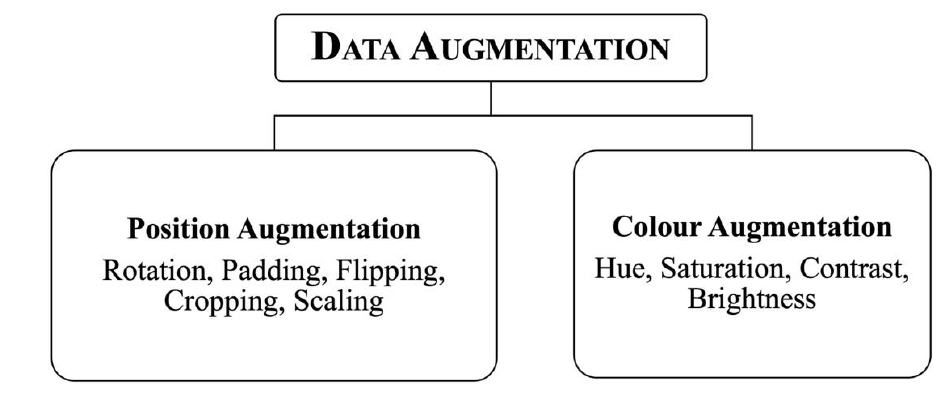
Figure 7. Data augmentation techniques.